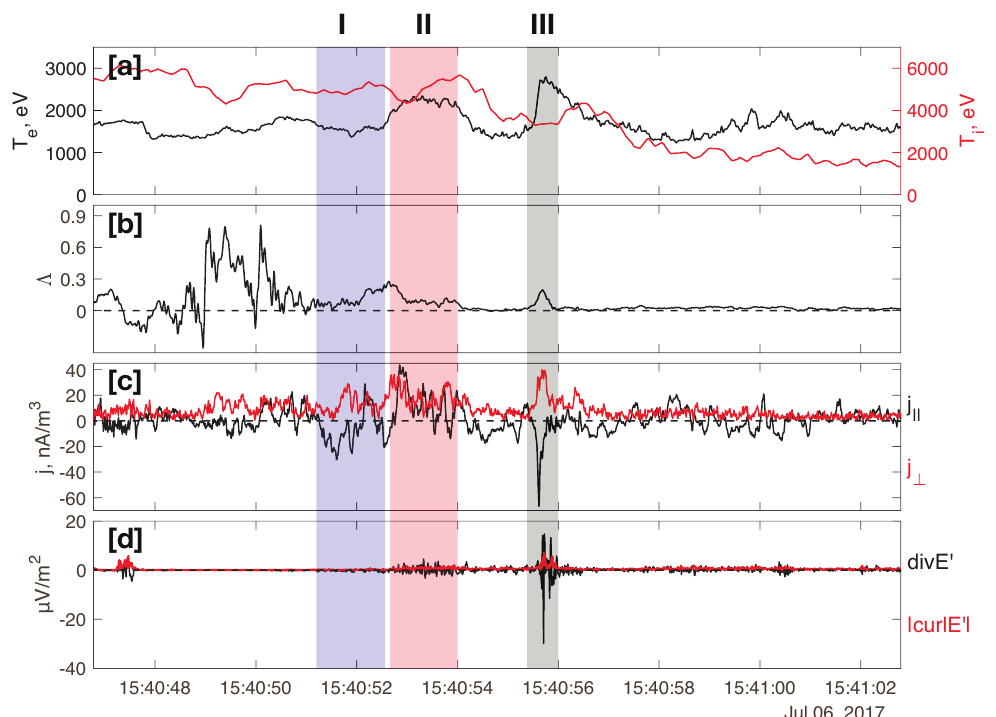
Figure 3. From top to bottom: ( a ) The time profiles of electron ( T e ) and ion ( T i ) temperatures. The corresponding values of T e and T i are shown in the left and right vertical axis, respectively. ( b ) Electron anisotropy Λ . ( c ) Parallel and perpendicular electric current density. ( d ) div( E (cid:48) ) and |curl( E (cid:48)